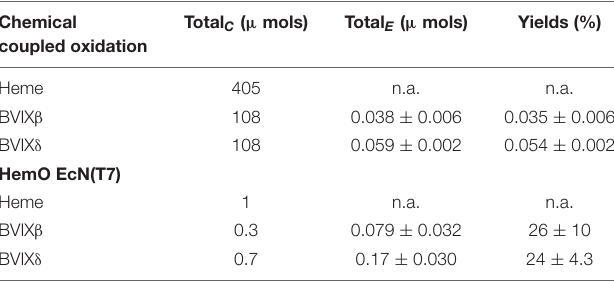
TABLE 1 | BVIX β , and - δ yields from coupled oxidation and HemO EcN(T7) BVIX production methods. Chemical coupled